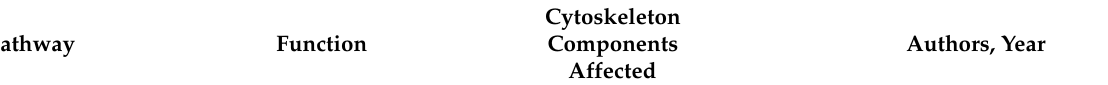
Table 2. Pathways that regulate the